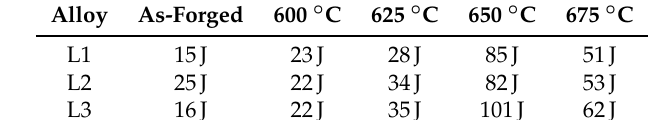
Table 2. Impact energy at room temperature after different annealing treatments.